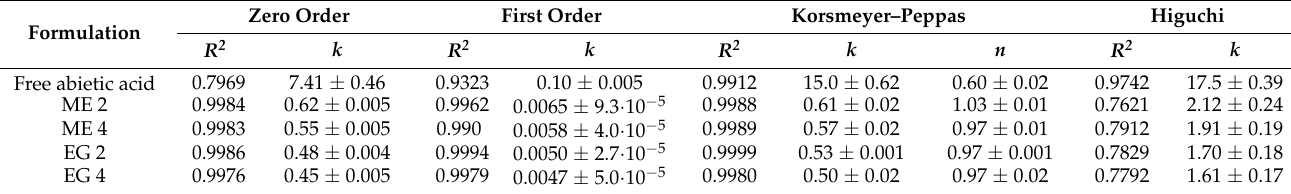
Table 3. Curve fitting results (Figure 2) for the different release models.